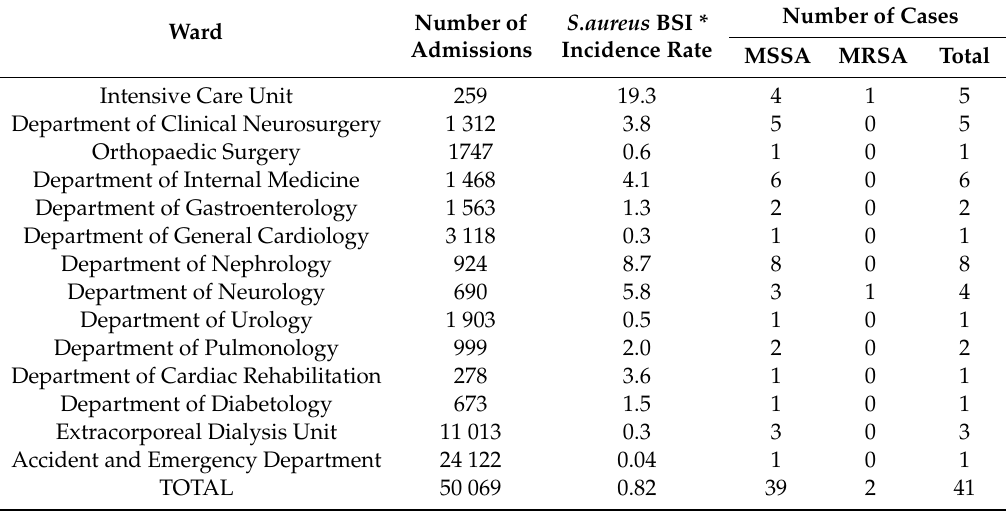
Table 1. Staphylococcus aureus bloodstream infections in Sosnowiec Hospital, Poland in 2019. Ward